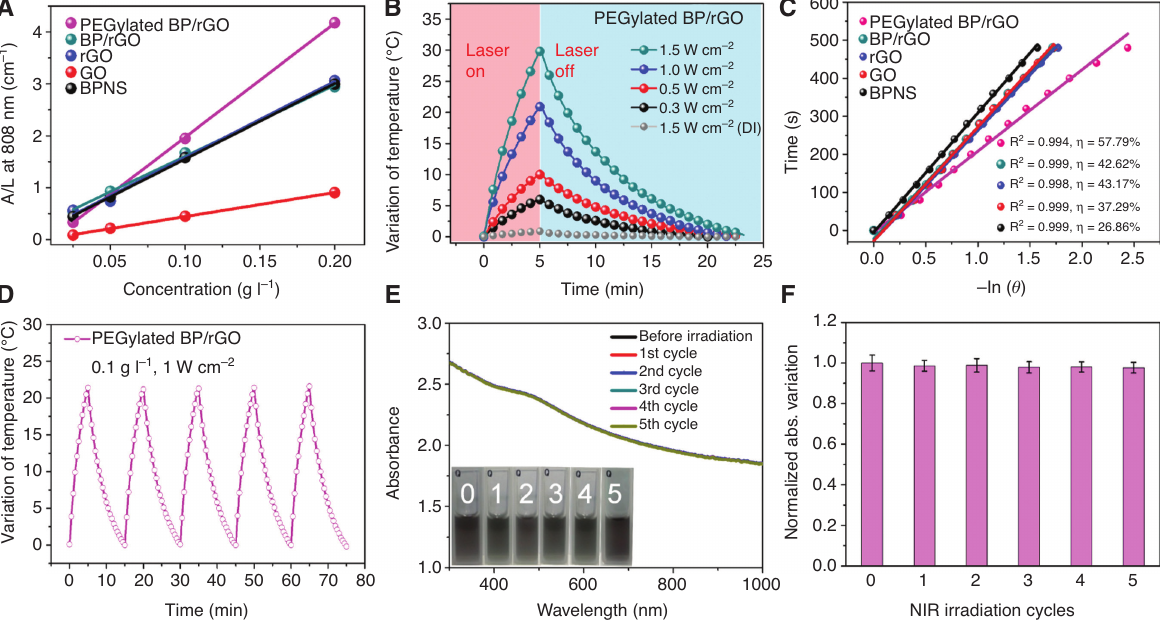
Figure 4: NIR extinctioncoefficients and photothermal properties. (A) The relationships of normalized absorbance over the optical path length of the cuvette (A/L, where L = 10 mm) for the dependence on the concentration (0.025, 0.05, 0.1, 0.2 g l −1 ) at 808 nm. (B) Temperature increments vs. NIR irradiation on/off time of PEGylated BP/ rGO aqueous solution (0.1 g l −1 ) under various power densities (0.3, 0.5, 1.0, 1.5 W cm −1 ). Deionized (DI) water was introduced here for comparison (in grey). (C) Comparison of time constants and photothermal conversion efficiencies of PEGylated BP/rGO, BP/rGO, rGO, GO, and BPNS at 808 nm. (D) Real-time temperature of PEGylated BP/rGO dispersed in PBS (0.1 g l −1 ) upon 1 W cm −1 incident illumination for five on/off cycles. (E) UV-vis absorbance spectra and photographs (inset) of PEGylated BP/rGO before and well after 1–5 NIR irradiation cycles. (F) Variation of the normalized absorbance of PEGylated BP/rGO at 808 nm. The data were extracted from